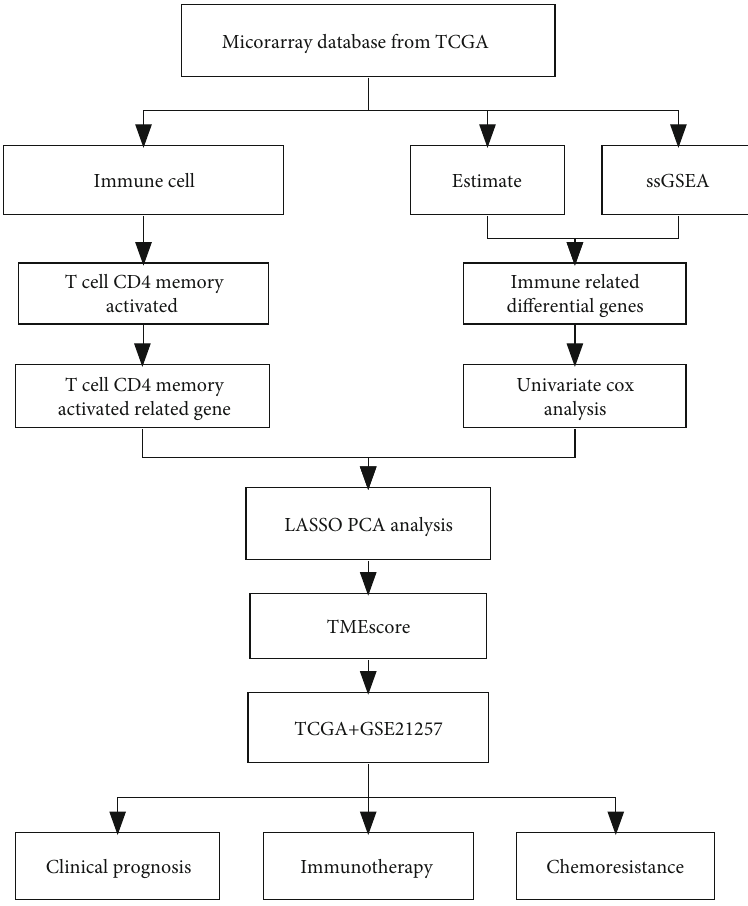
Figure 1: Flow diagram of the study